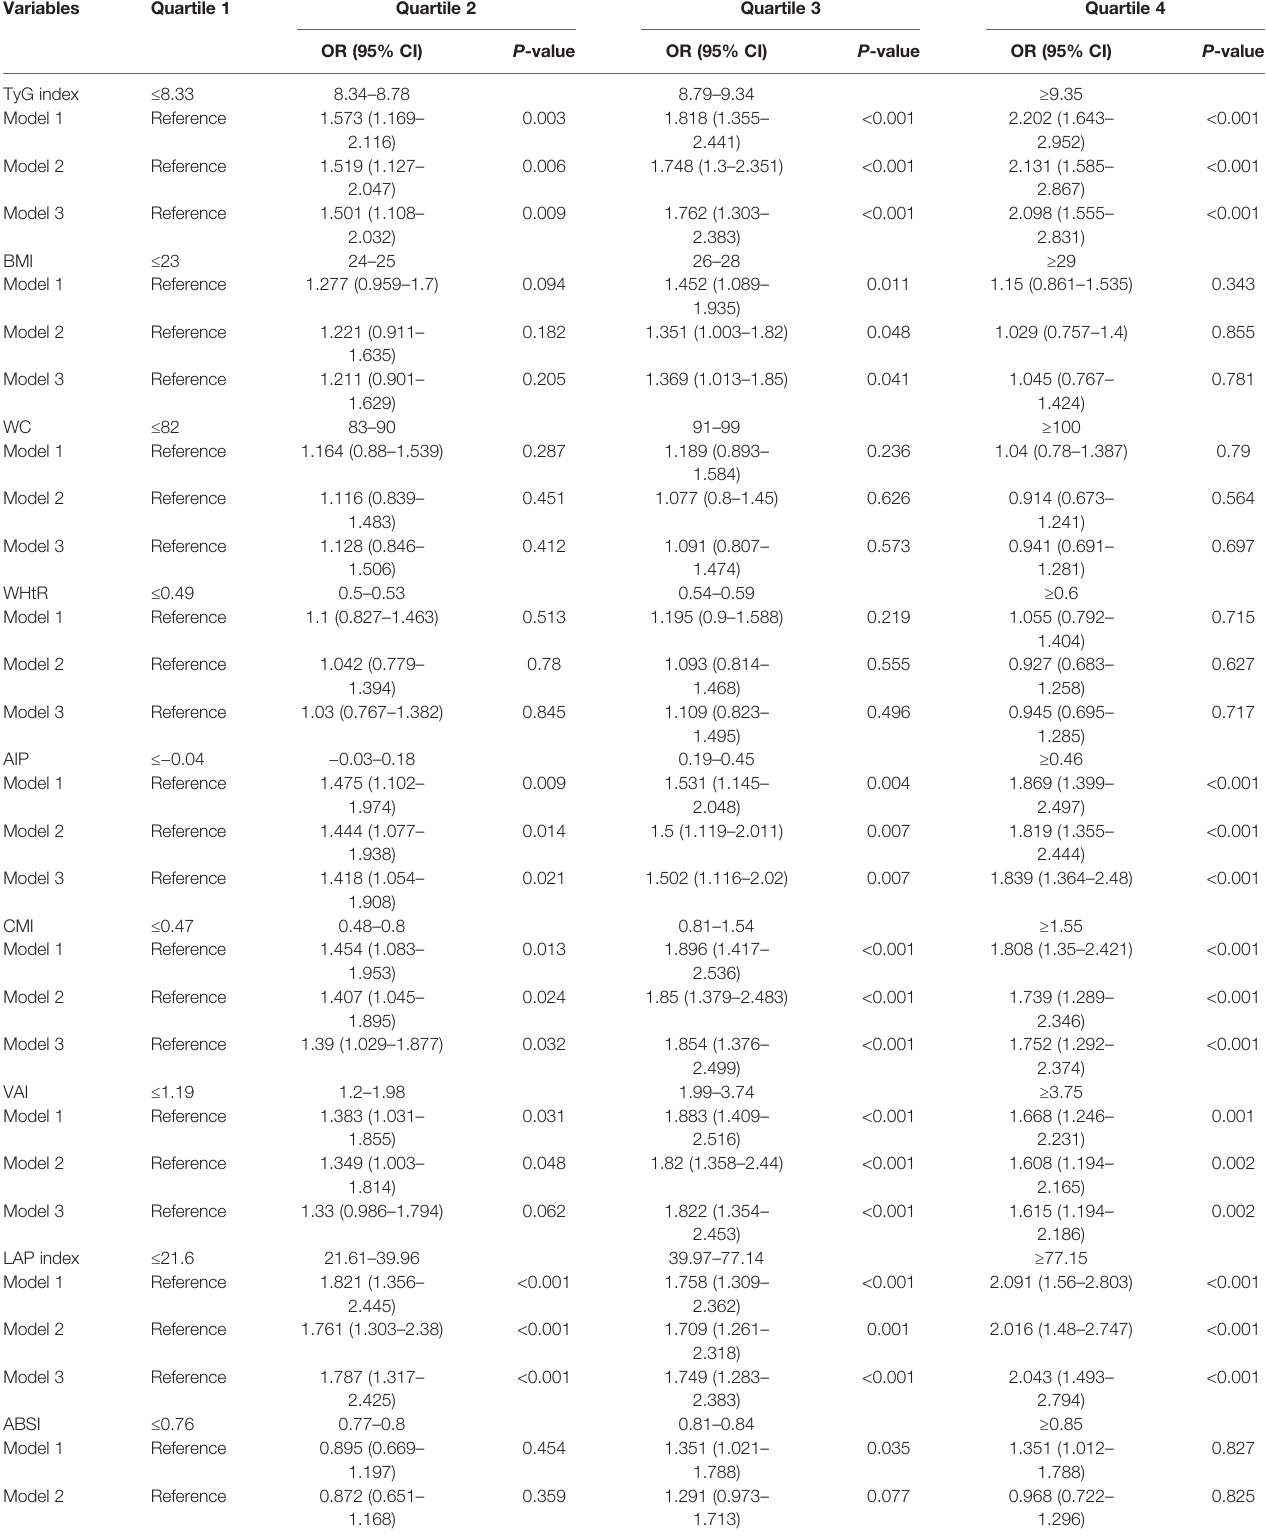
TABLE 3 | Multivariate logistic regression of different indices for HUA